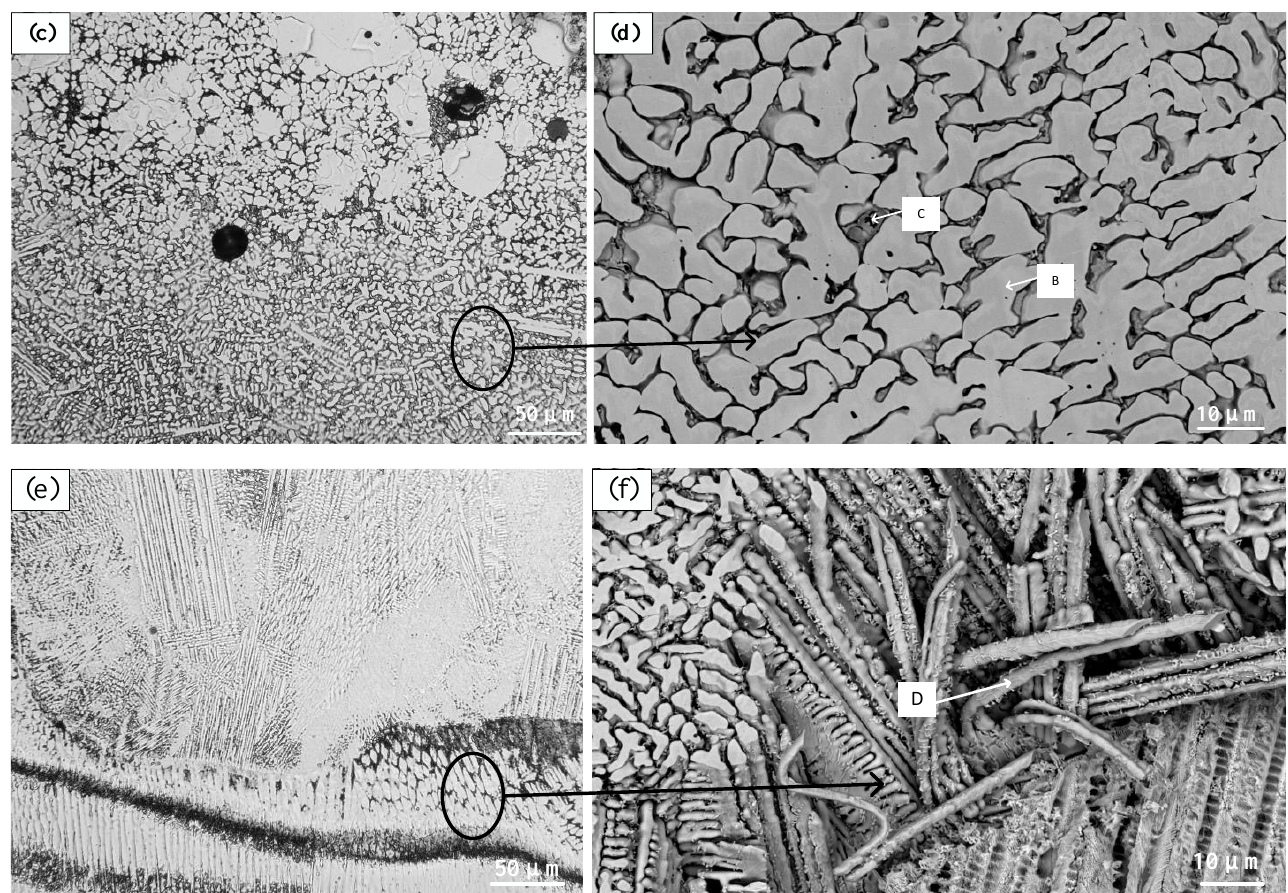
Figure 5. Microstructure from Mo to Ni-Cu layer: ( a ) microstructure of the Mo layer; ( b ) enlarged view of the microstructure of the Mo layer; ( c ) microstructure of the middle part of the Mo-Ni-Cu mixed layer; ( d ) enlarged view of the microstructure of the middle part of the Mo-Ni-Cu mixed layer; ( e ) microstructure of the bottom of the Mo-Ni-Cu mixed layer; ( f ) enlarged view of the microstructure of the bottom of the Mo-Ni-Cu mixed layer.